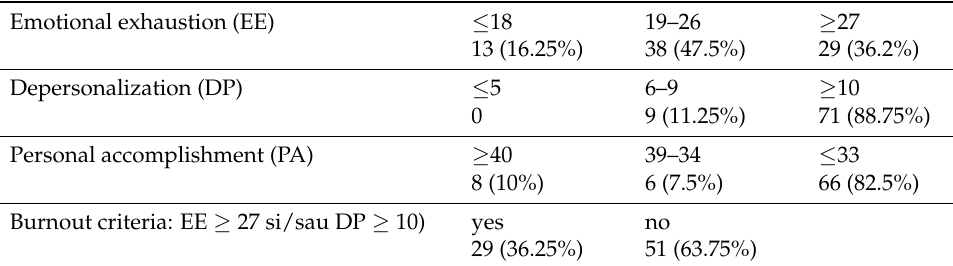
Table 2. MBI-HSS scores; Nurses N =